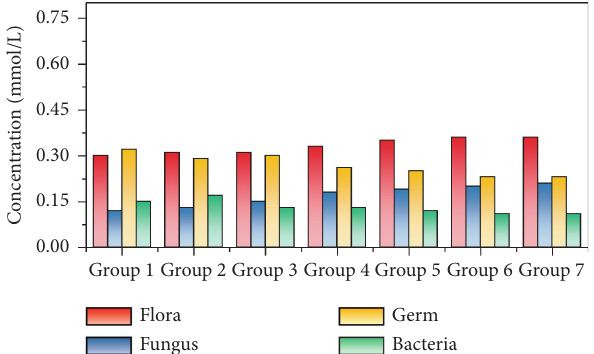
Figure 7: Microbial concentration assessment